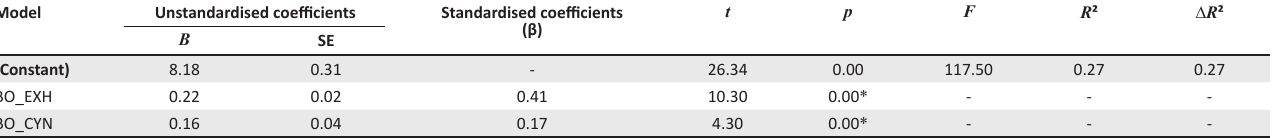
TABLE 5: Multiple regression with anxiety and insomnia (general health) being the dependent variable and emotional exhaustion and cynicism (burnout) being the dependent variables. Model